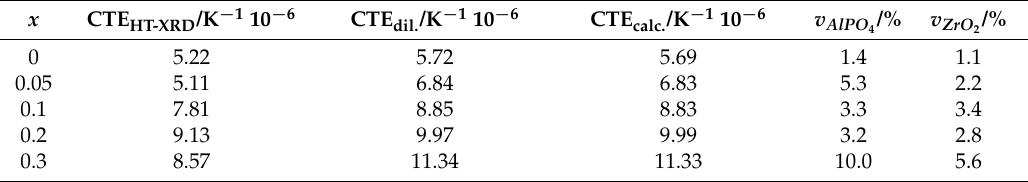
Table 3. CTEs between room temperature and 700 °C of NAYZSiP x and the used volume fractions of AlPO 4 and ZrO 2 for calculating the CTE according to Equation (4).